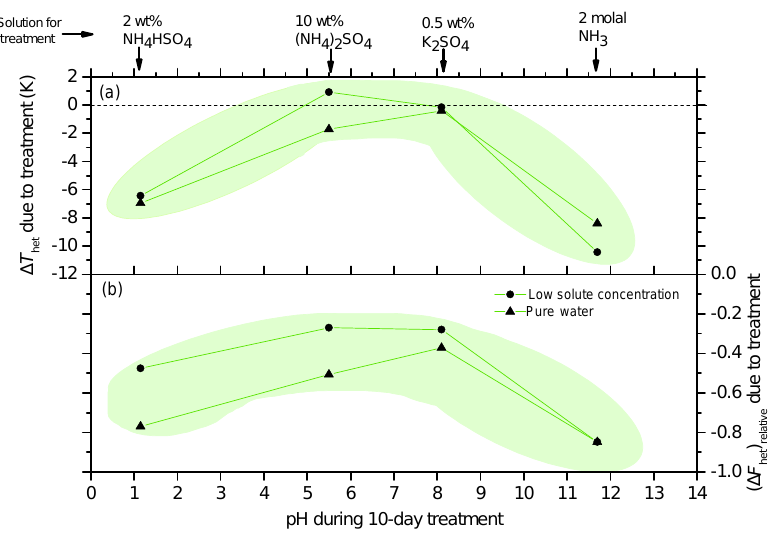
Figure 8. Aging of 2wt% microcline suspended in 10wt% ( NH 4 ) 2 SO 4 , 2wt% NH 4 HSO 4 , 0.5wt% K 2 SO 4 or 2 molal NH 3 solu- tions for 10 days, sorted according to the solution pH. After the treatment, the particles were centrifuged, washed and resuspended in pure water or dilute solutions (0.1wt% ( NH 4 ) 2 SO 4 , 0.5wt% NH 4 HSO 4 , 0.05wt% K 2 SO 4 , 0.05 molal NH 3 ) and then freezing measured using DSC. (a) Difference in T het between particles treated in such a way and particles freshly suspended in pure water or very dilute solutions. Dashed black line: (cid:49)T het = 0 shown to guide the eye. (b) Relative decrease in heterogeneously frozen fraction, ((cid:49)F het ) relative = ( F het , treated − F het , fresh ) /F het , fresh . The green shaded area in both panels depicts a suggested range for (cid:49)T het and F het based on the results from this